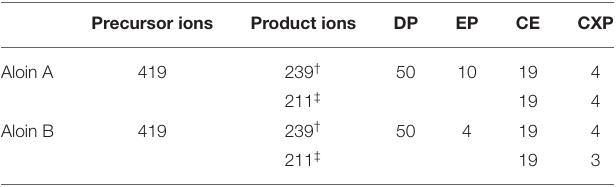
TABLE 1 | Multiple reactions monitoring (MRM) for aloin A and aloin B detected in the extract. Precursor ions